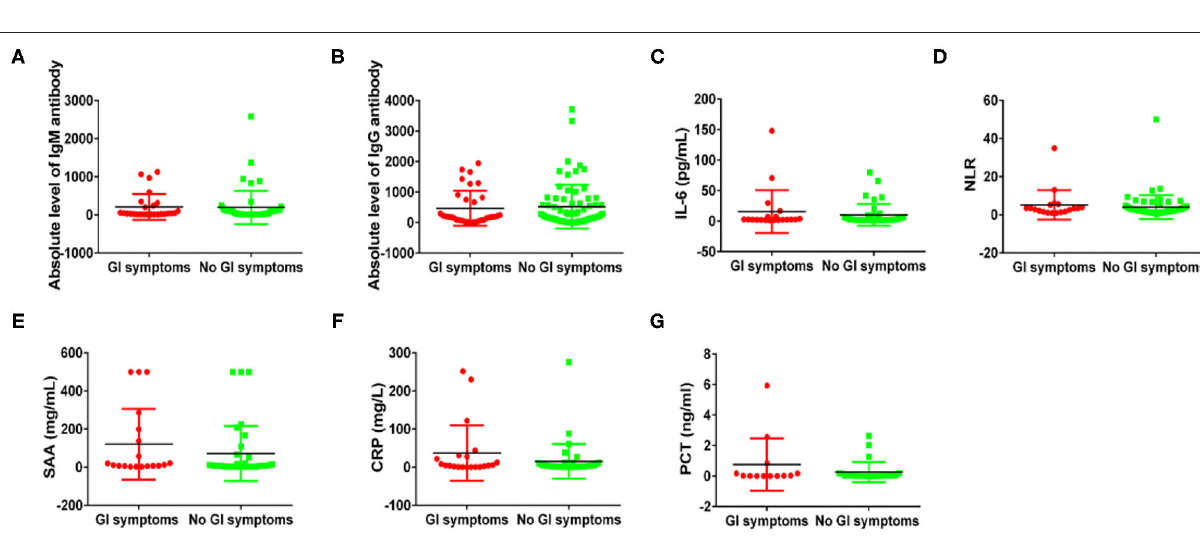
FIGURE 2 | Immune response phenotyping in COVID-19 patients with and without GI symptoms according to the expression level. Comparing IgM levels (A) , IgG levels (B) , IL-6 levels (C) , NLR levels (D) , SAA levels (E) , CRP levels (F) , and PCT levels (G) between patients with and without GI